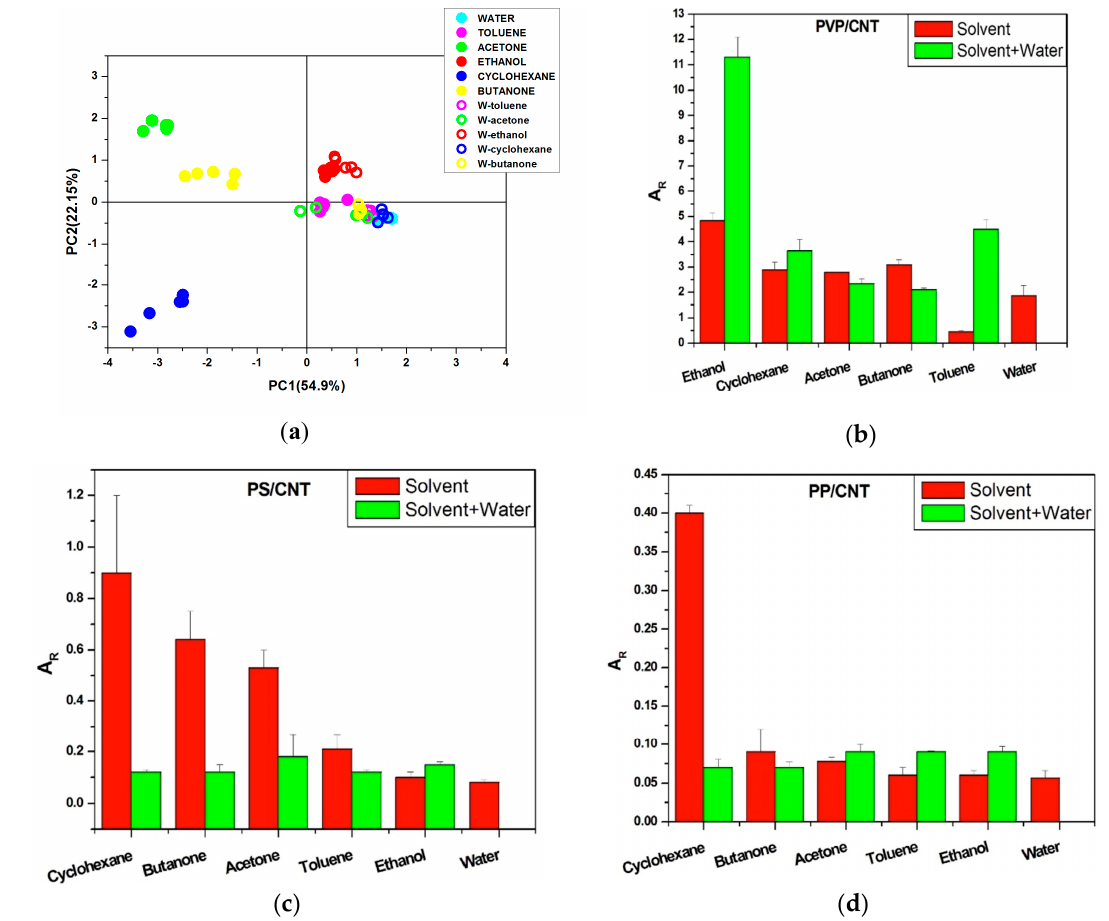
Figure 3. ( a ) Principal component analysis (PCA) for pure VOC responses (solid circles) and water-VOC mixtures (hollow circles) in saturated vapor conditions, and Maximum relative amplitudes A r of ( b ) PVP-CNT sensor, ( c ) PS-CNT sensor and ( d ) PP-CNT sensor exposed to pure solvent and their mixture with water.